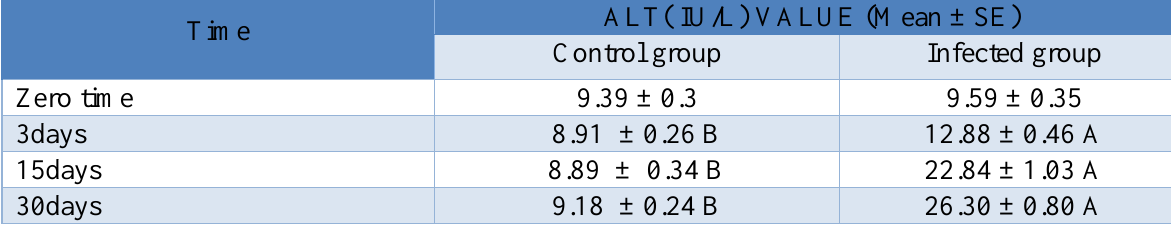
Table, 2: Effect of E.coli infection on ALT( IU/L) value of infected group compared with control group at zero time, 3, 15 and 30 days post infection.